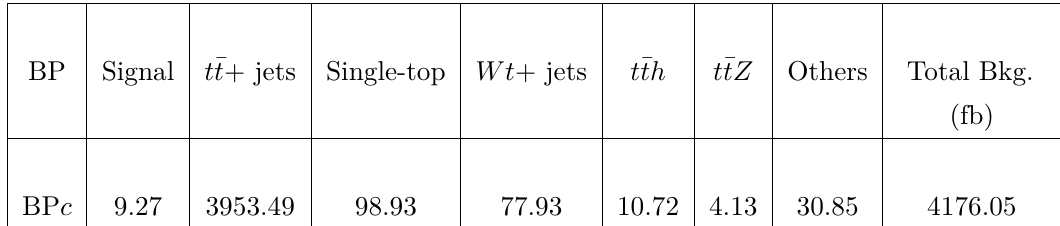
Figure 9 . The normalized missing energy E miss leading backgrounds.